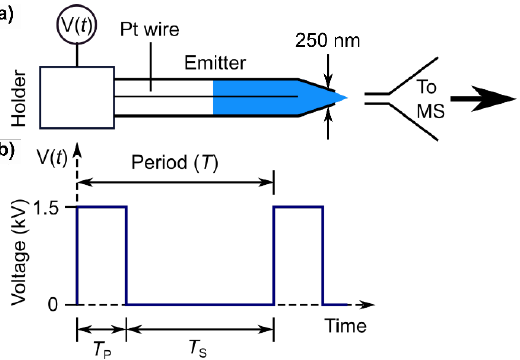
Figure 1. Diagram of pulsed nanoelectrospray ionization mass spectrometry. ( a ) A borosilicate capillary emitter pulled to an inner diameter of ~250 nm. The emitter was filled with a sample solution (blue); a thin platinum wire was inserted to apply the spray voltage into the solution. ( b ) A pulsed, positive polarity high voltage potential was applied to the emitter relative to the capillary entrance to the mass spectrometer (MS), which had sub-nanosecond rise times, pulse widths ( T P ) from 2.85 to 100 µs, and a delay between pulses ( T S ) of 0.25 to 90 µs.